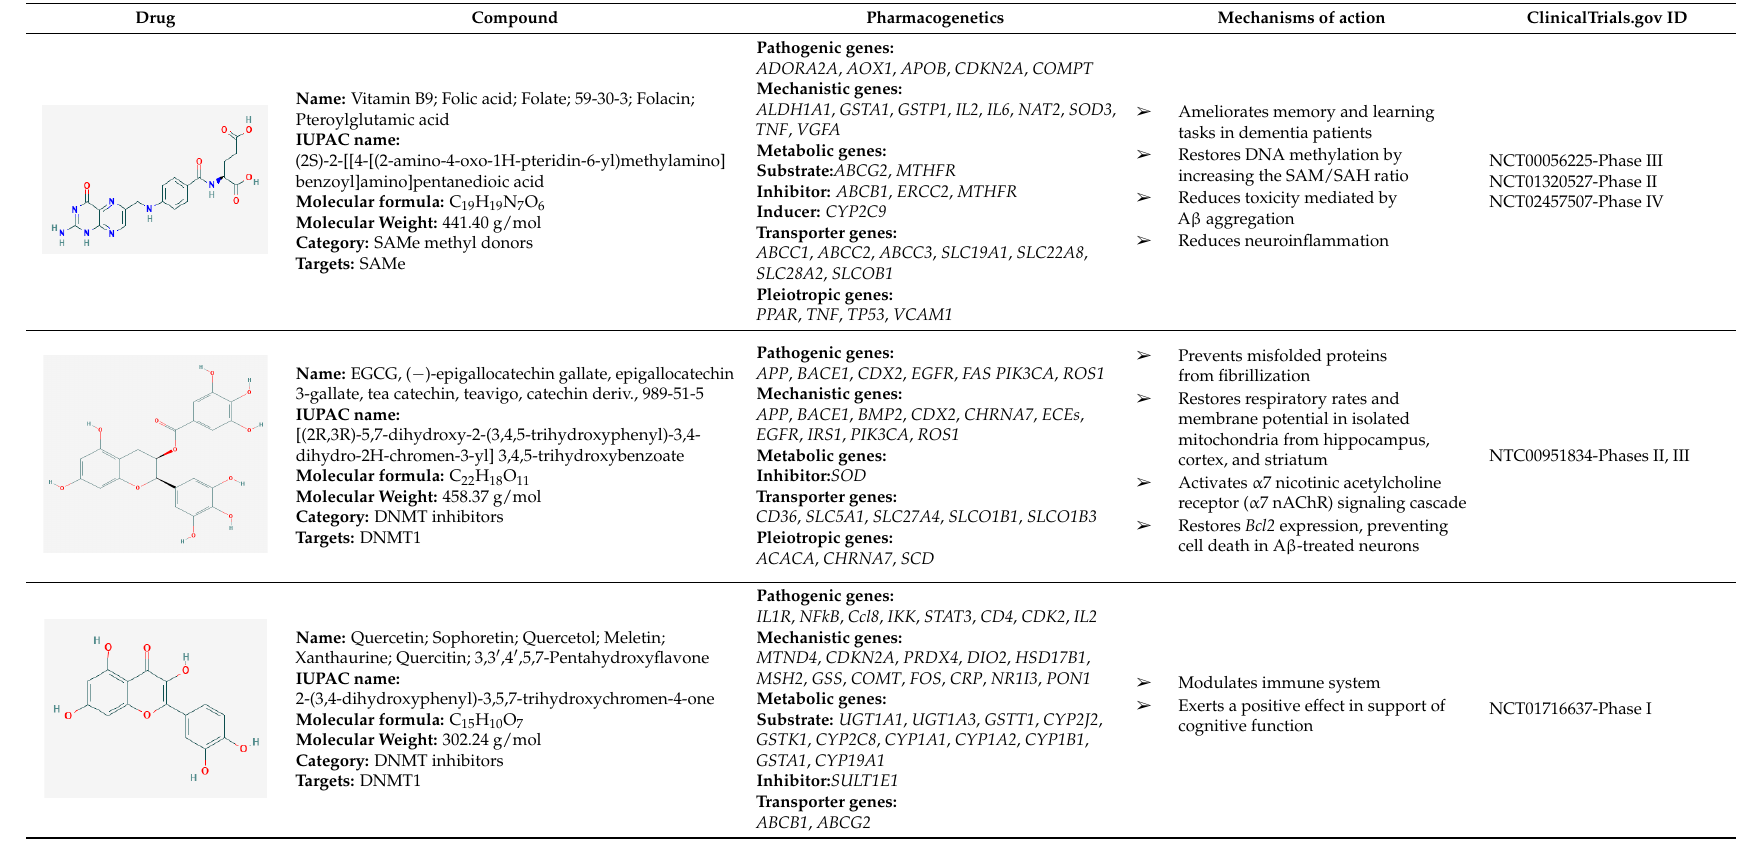
Table 1. Pharmacogenetic profiles of epigenetic-based compounds currently submitted to clinical trials for the treatment of Alzheimer’s and Parkinson’s diseases. Drug Compound